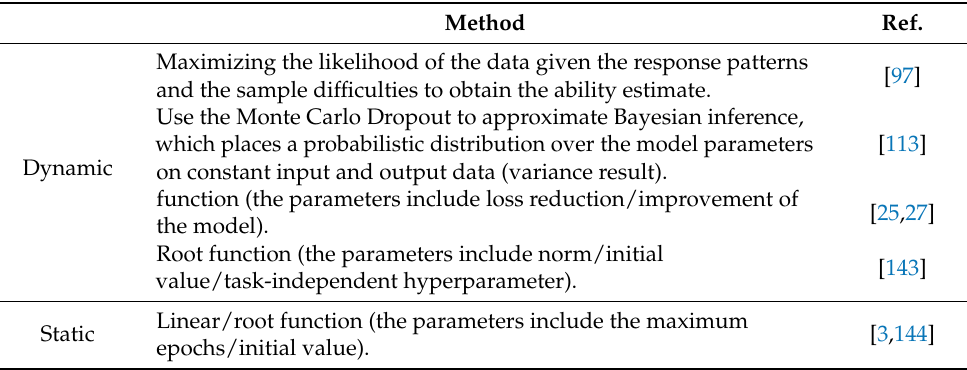
Table 3. Summary of model competence estimation methods.